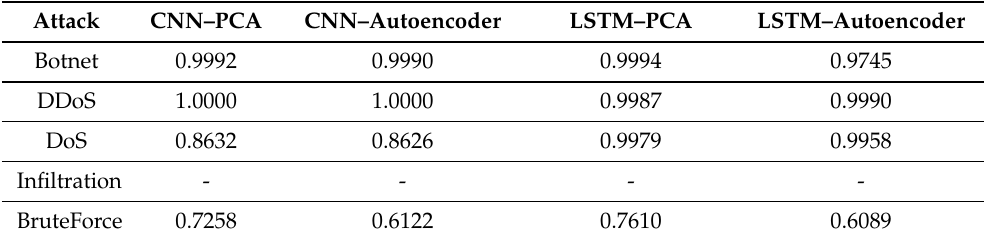
Table 12. Averages of the F1 measure obtained for each pair of deep learning and feature reduction methods, and for each attack type.